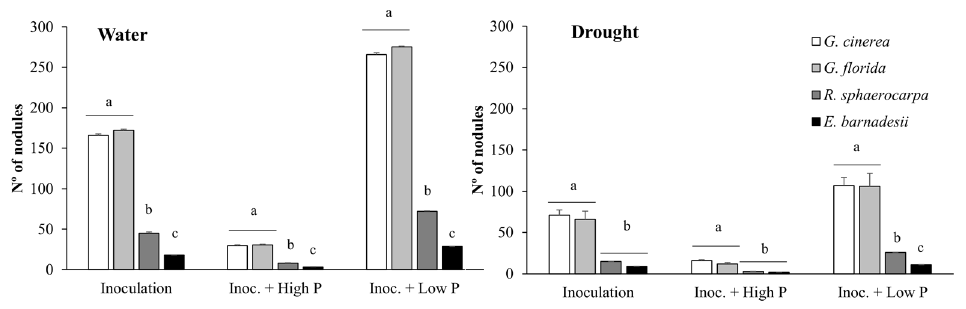
Figure 4. Number of nodules per plant of G. cinerea , G. florida , E. barnadesii and R. sphaerocarpa grown